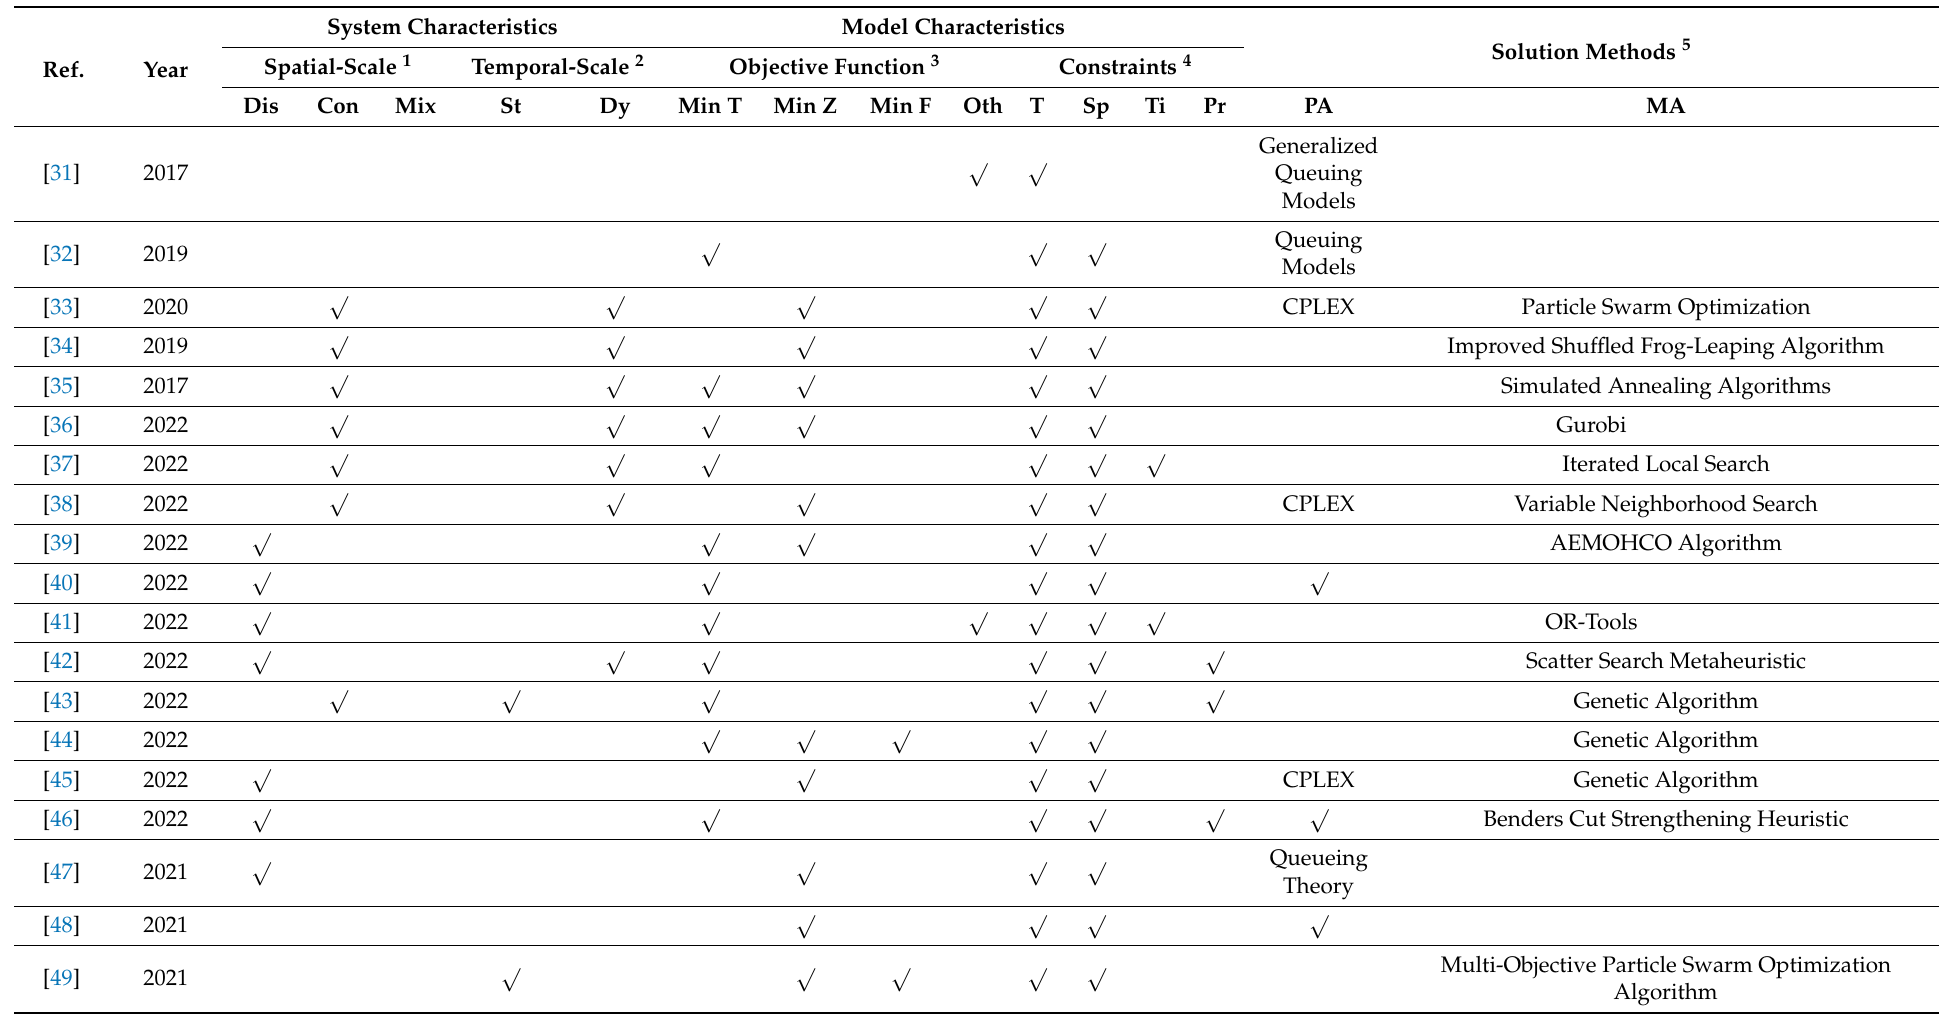
Table 5. Overview of research on terminal/berth scheduling